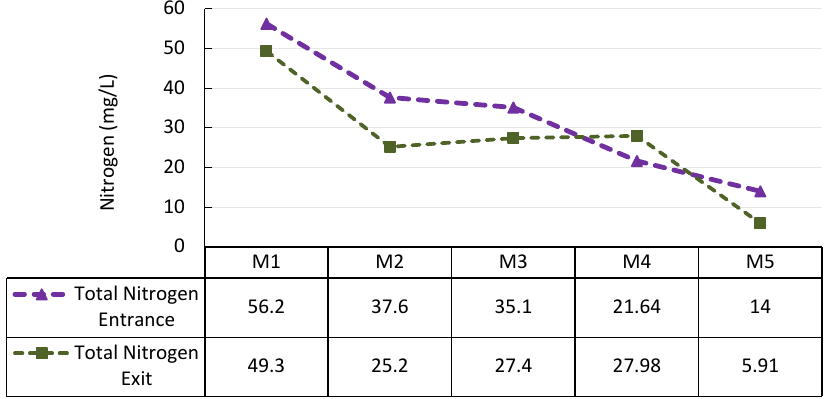
Fig. 8: Nitrogen content of the treated and untreated effluents of the 5 sampling